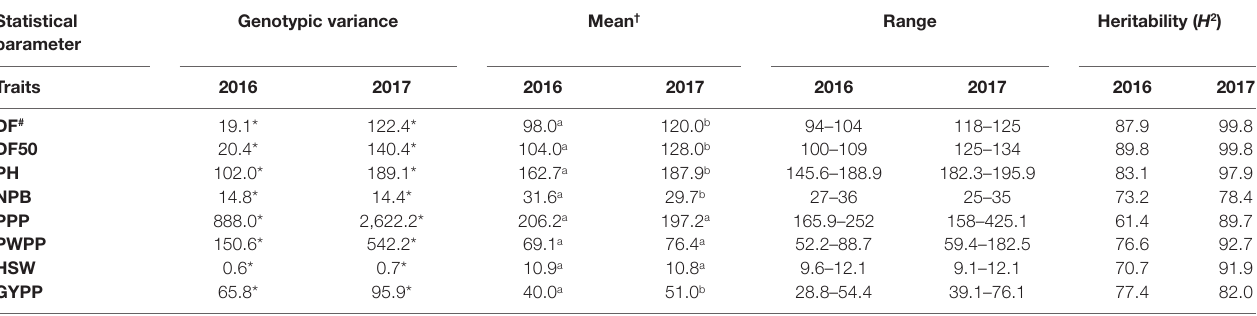
TABLE 5 | Variance components due to genotypes ( ) σ g 2 , mean, range, and heritability ( H 2 ) of agronomic traits in Trial 04 at ICRISAT Patancheru during the 2016 and 2017 rainy seasons. Statistical